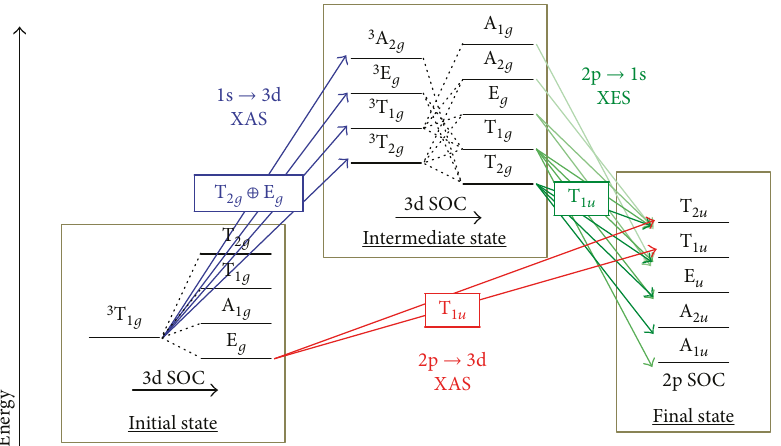
Figure 25: Multielectronic term scheme for Cr 4+ ( 3d 2 ) comparing the 1s2p RIXS and direct 2p XAS pathways. Where SOC is included, the spin multiplicity is omitted as its meaning is lost in that